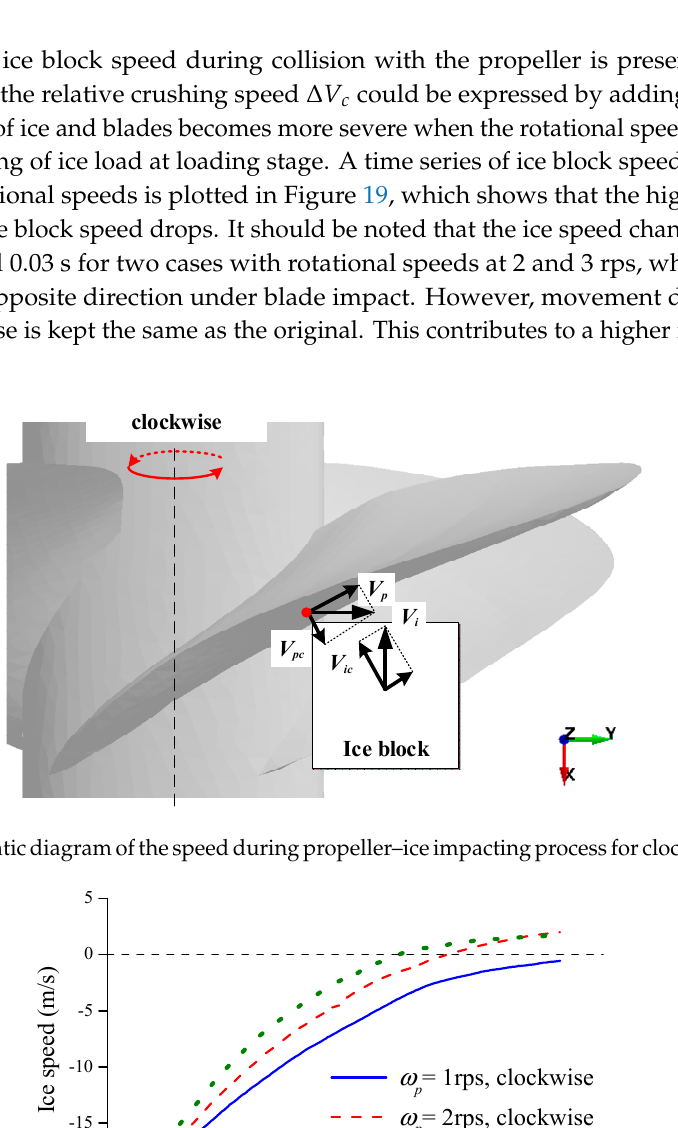
Figure 17. Time series of ice load Fx and Mx based on simulations with different rotation speeds for clockwise rotation. ( a ) The Fx with different rotation speed. ( b ) The Mx with different rotation speeds.